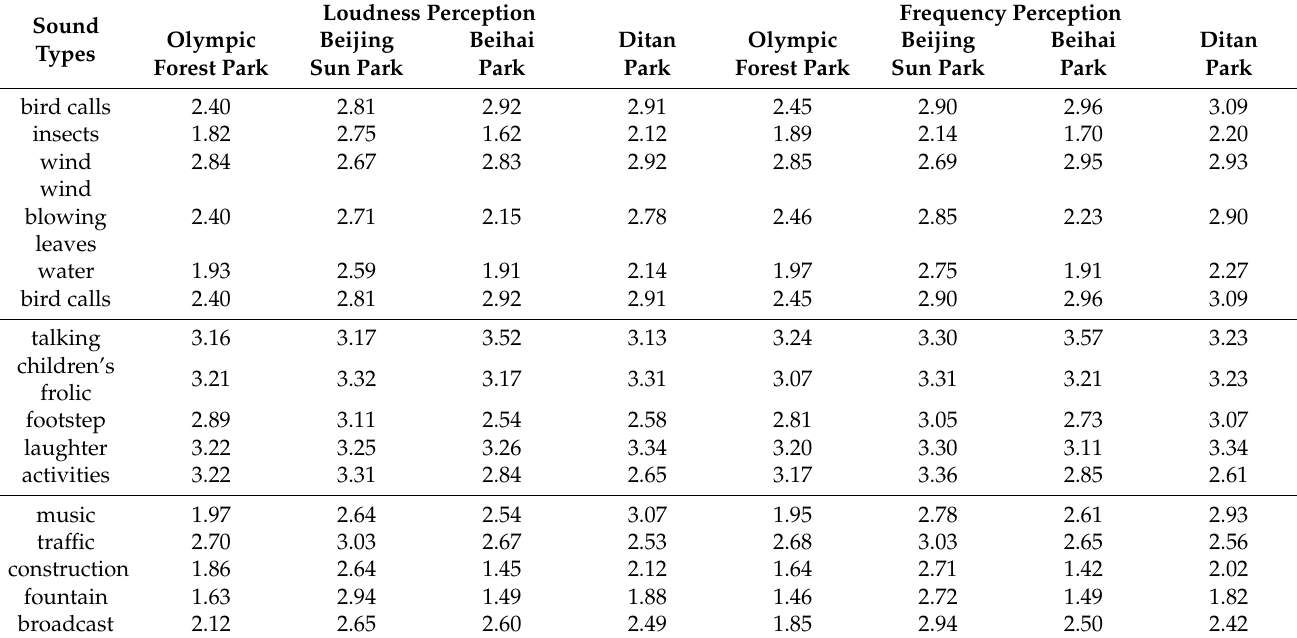
Table 3. The results of citizens’ perception of